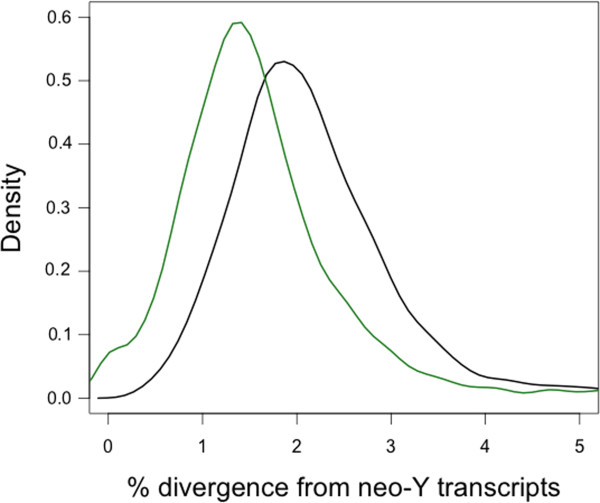
Density plot of the total divergence between the assembled neo-Y transcripts compared to neo-X (green) and
D. pseudoobscura
(black) transcripts, respectively.